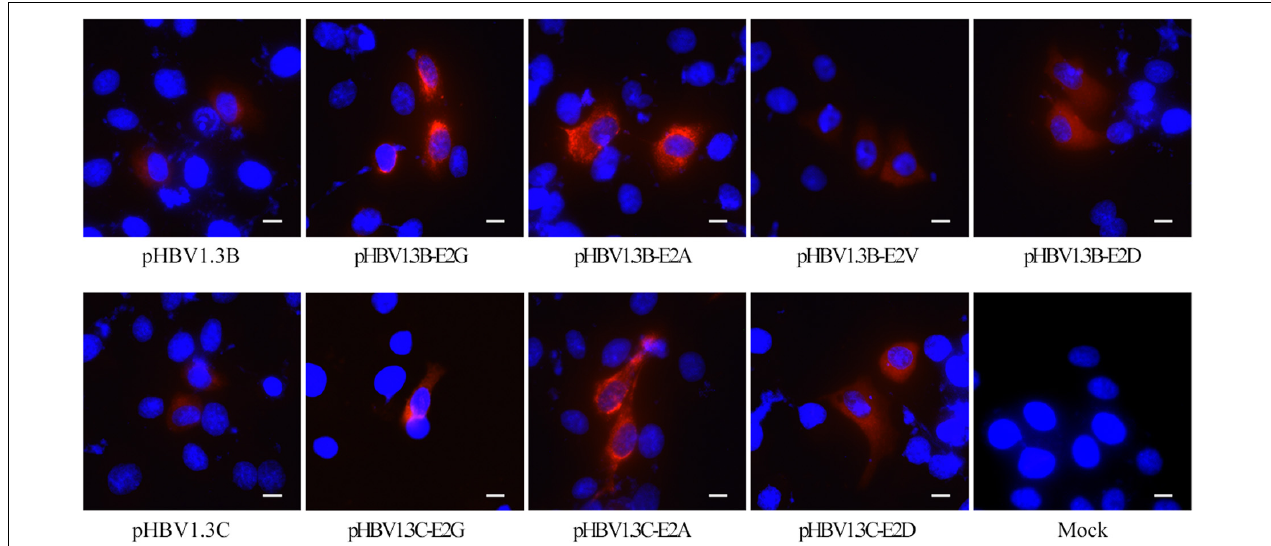
FIGURE 2 | Immunofluorescence staining of HBsAg in HepG2 cells transfected with pHBV1.3B/C and E2 mutated plasmid. The staining of HepG2 cells transfected with pHBV1.3B/C showed a diffuse fine particle staining, while cells transfected with pHBV1.3B/C-E2G/A gathered in the perinuclear region or showed a flaked and coarse grains staining pattern. The staining of cells transfected with pHBV1.3B-E2V/D and pHBV1.3C-E2D was similar to that of genotype-matched pHBV1.3B/C. The cells were fixed at 48 h after transfection and staining with a monoclonal rabbit antibody to the HBsAg, followed by an anti-rabbit IgG conjugated with CY3 (red). The cell nuclei were stained with DAPI (blue). The scale bar stands for 10 µ m. Magnification, × 200 or × 400. Mock: pcDNA3.1(+) vector.